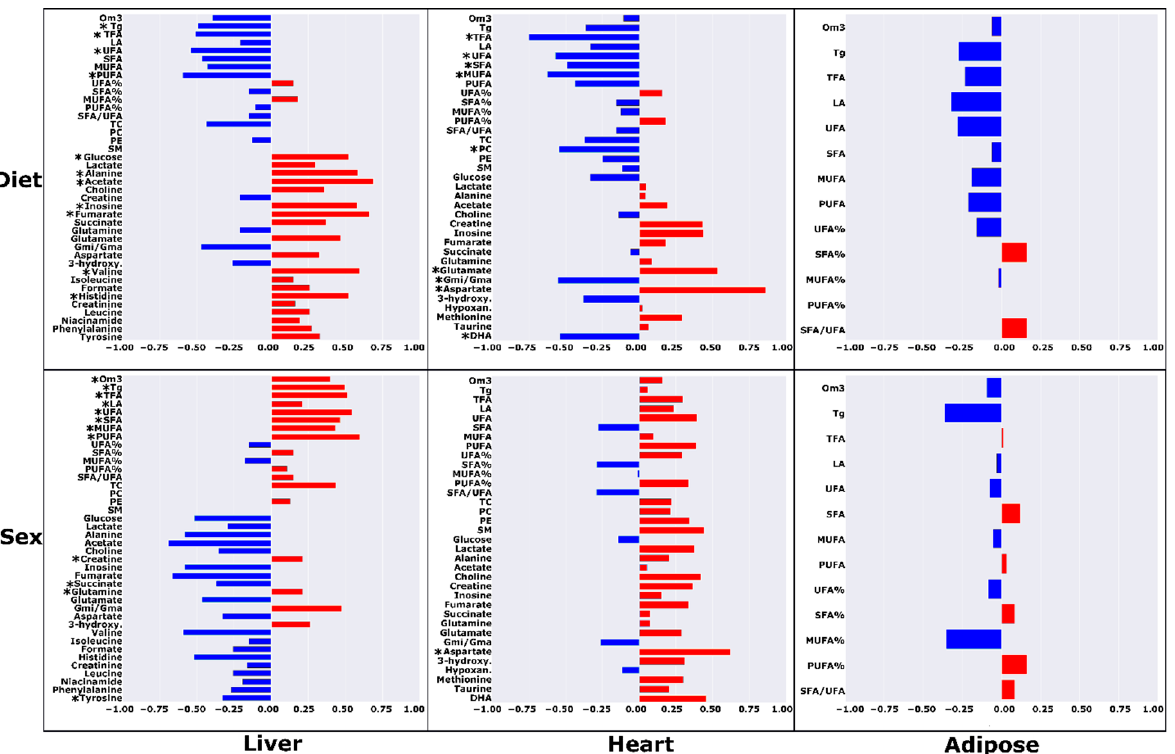
Figure 6. Correlations between metabolite concentration levels with diet and sex in high-fat ad libitum (HF-AD) and time-restricted evening (HF-PM) dietary groups. For dietary partial correla- tions, metabolites with negative coefficients are lower in HF-PM, and with positive correlation co- efficients are higher compared to HF-AD. For sex partial correlations, metabolites with positive correlation coefficients are higher in females, and vice versa for negative coefficients compared to males. The metabolites with significant partial correlations ( p < 0.05) are denoted with asterisks (*). Abbreviations: Tg = triglycerides; PC = phosphatidylcholine; SM = sphingomyelin; PE = phospha- tidylethanolamine; LA = linoleic acid; DHA = docosahexaenoic acid; MUFA = monounsaturated fatty acids; PUFA = polyunsaturated fatty acids; UFA = unsaturated fatty acids; SFA = saturated fatty acids; Om3 = omega-3 fatty acids; TFA = total fatty acids; TC = total cholesterol; 3-hydroxy. = 3-hydroxybutyrate; Hypoxan. = hyphoxanthine; Gmi/Gma = ratio of glutamine to glutamate.